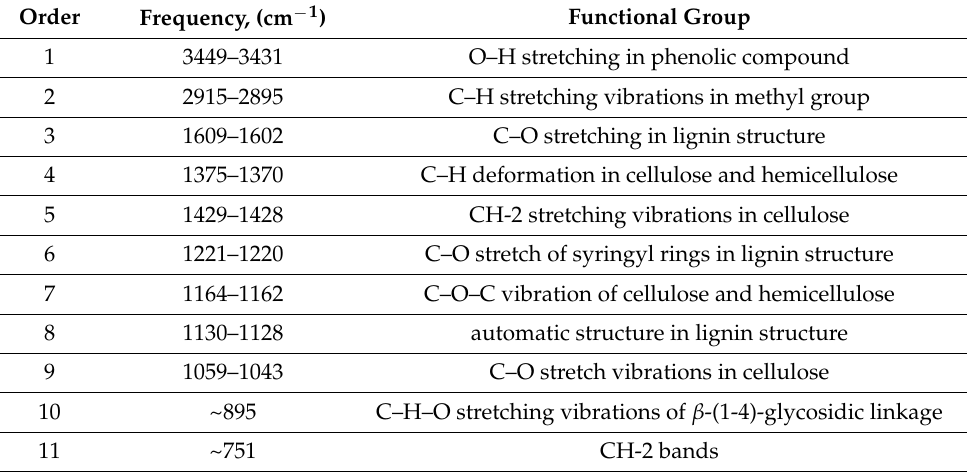
Table 4. FTIR spectra of the native sugarcane bagasse and solid residual after pretreatment process under suitable